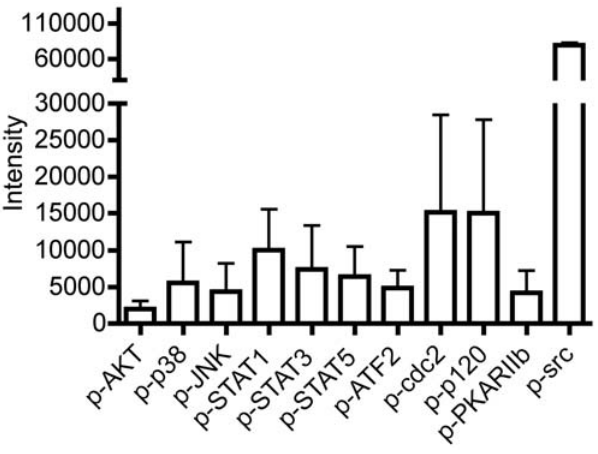
Figure 1. Phospho-specific epitopes are activated in RA synovial tissue lymphocytes. Cell lysates were prepared from ST lymphocytes isolated from the affected joints of 3 patients with late- stage RA, at the time of joint replacement, as described in Methods. Lysates were analyzed by a customized BD PowerBlot and data are shown as mean 6 SE. Values represent the average intensity of triplicate readings except for p-JNK, p-STAT5, p-cdc2 and p-src, which are averages of duplicate